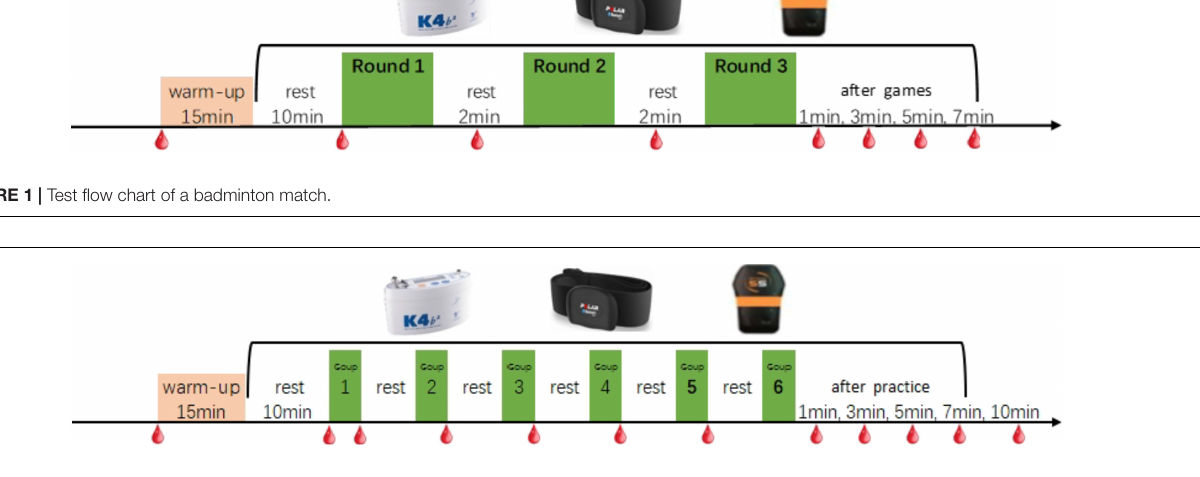
FIGURE 2 | Test flow chart of multi-ball stroke practice for each